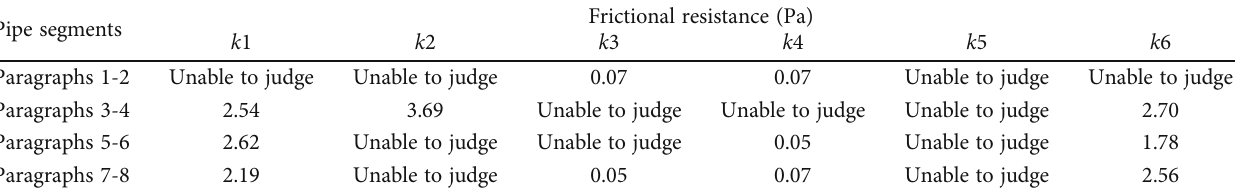
Table 5: Frictional resistance datasheet of transverse